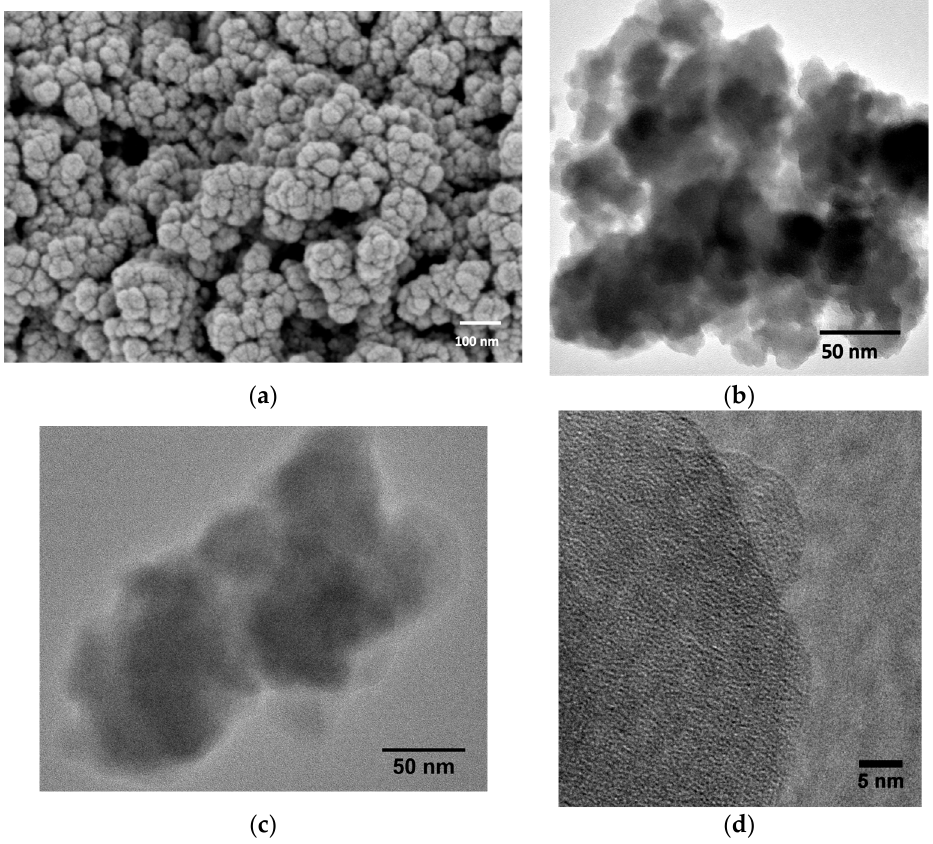
Figure 3. Morphology of Fe(III)-TA microstructure: ( a ) SEM image; ( b – d ) HR-TEM images repre- senting pore